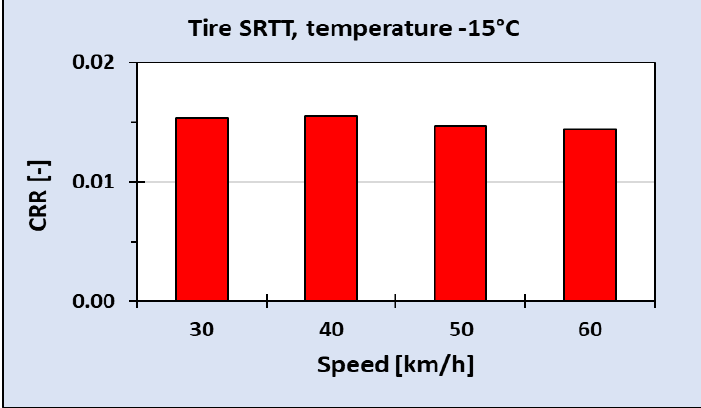
Figure 27. Coefficient of Rolling Resistance (CRR) for SEPOR-D-PSMA5 W4 as measured on the roadwheel facility at − 15 °C.